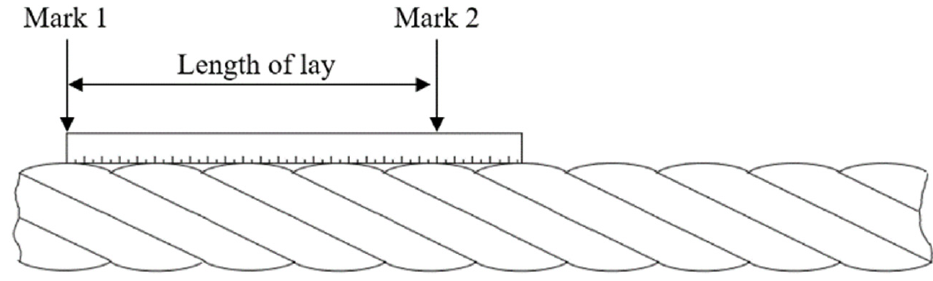
Figure 3. Measurement of the length of lay.